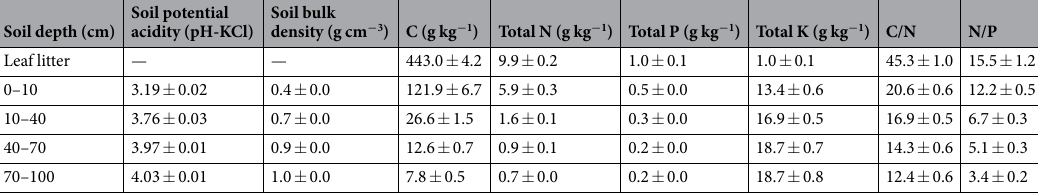
Table 1. Physicochemical properties of soil and leaf litter in a secondary evergreen broad-leaved forest near Wawushan Mountain, SW China (Mean ± 1 SE, n =